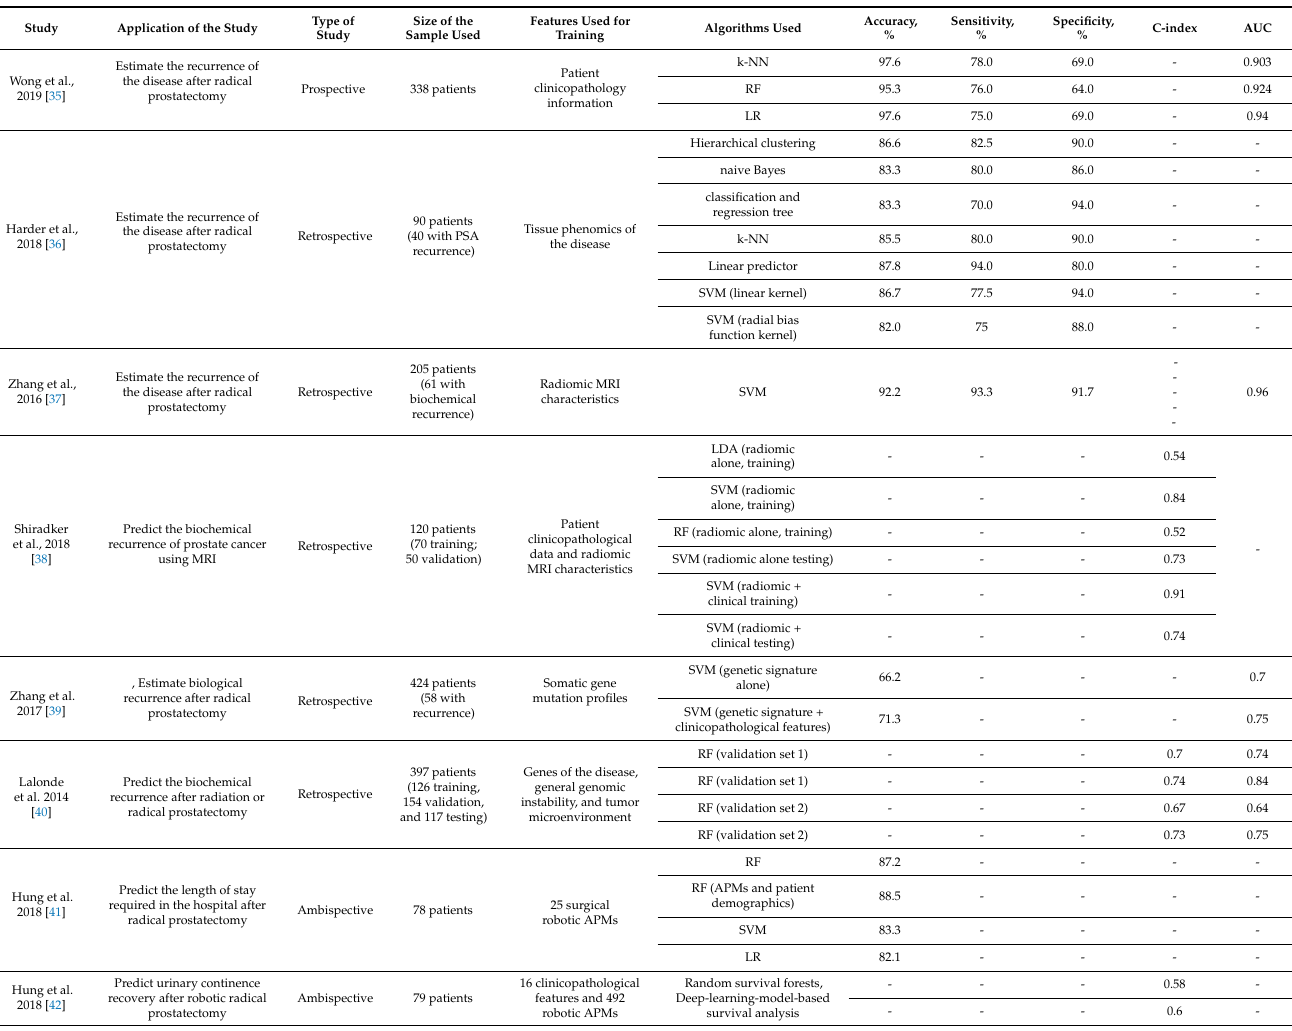
Table 5. Studies using AI to predict outcomes of urothelial